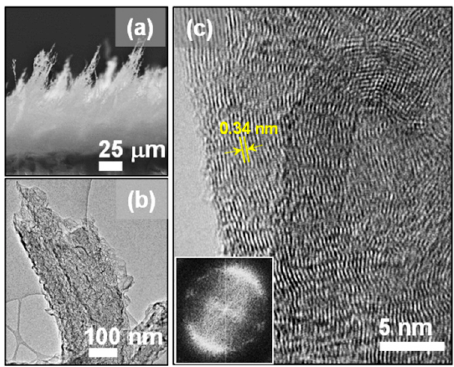
Figure 2. ( a ) Cross-sectional view FESEM micrograph of laser-induced graphene nanoribbons (LIGNs). ( b ) TEM micrograph and ( c ) high-resolution TEM (HRTEM) structural image of the LIGNs. The inset in ( c ) shows the Fourier transformed image corresponding to the whole structural image in ( c ).